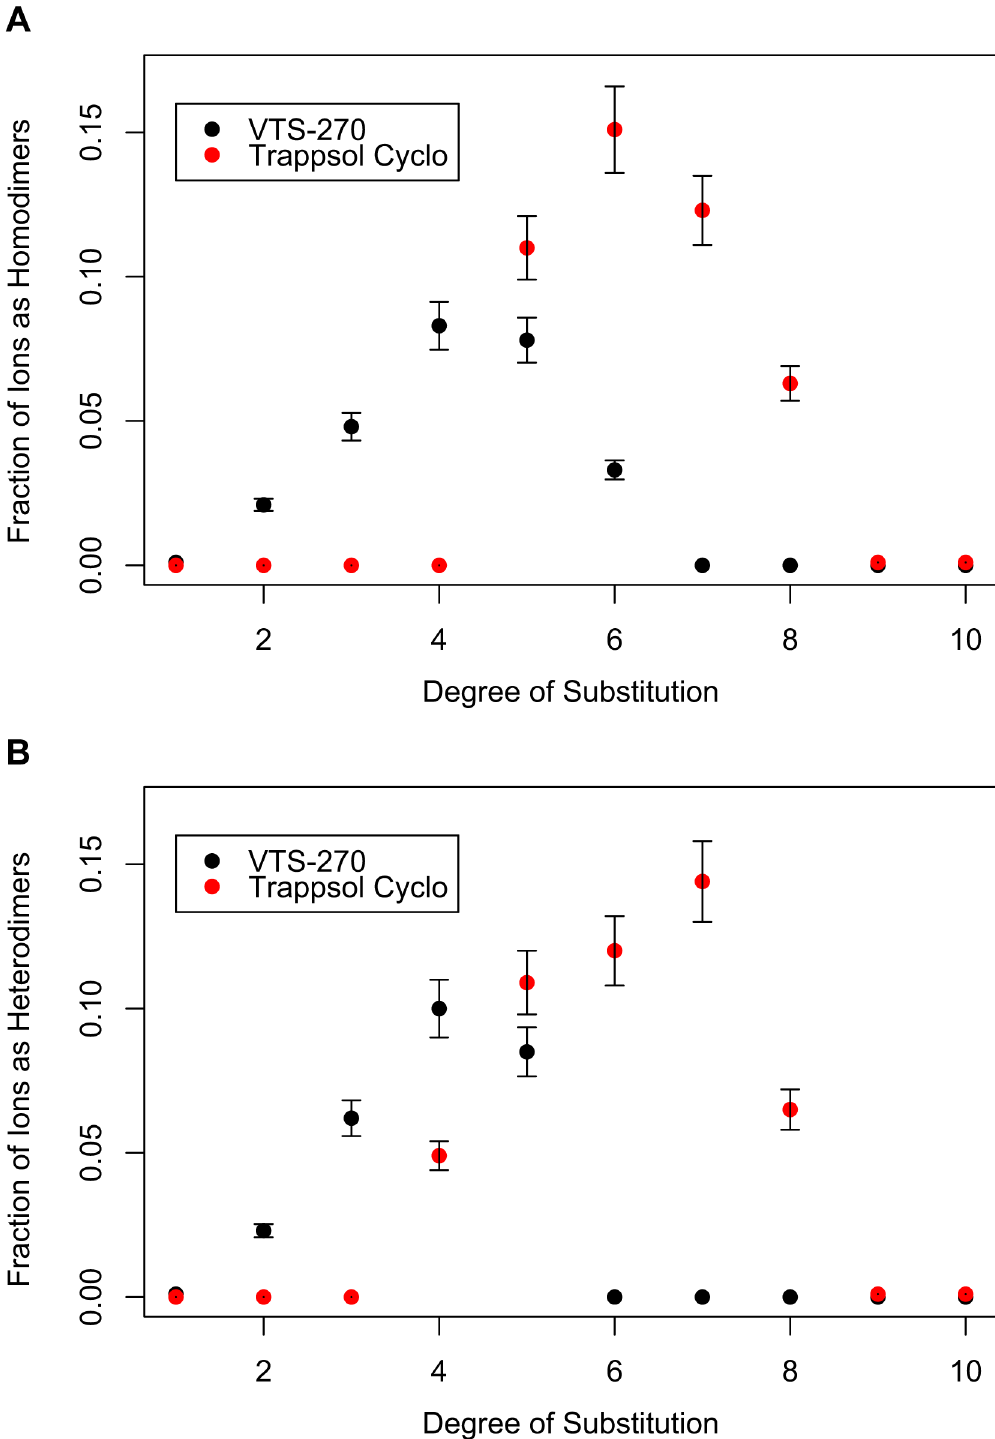
Fig 5. Fraction of dimers as a function of the degree of substitution. Fractional intensity of homodimer ions, relative to total hydroxypropyl-beta-cyclodextrin (HP β CD) ion signal, plotted as a function of the degree of substitution (A); fractional intensity of heterodimer ions, relative to total HP β CDion signal, plotted as a function of the degree of substitution (B). The fractional intensity of ions as heterodimers and homodimers is greater with Trappsol Cyclo (red circles) than with VTS-270 (green triangles). The points represent the mean value ± standard deviation of 4 replicate measurements of each